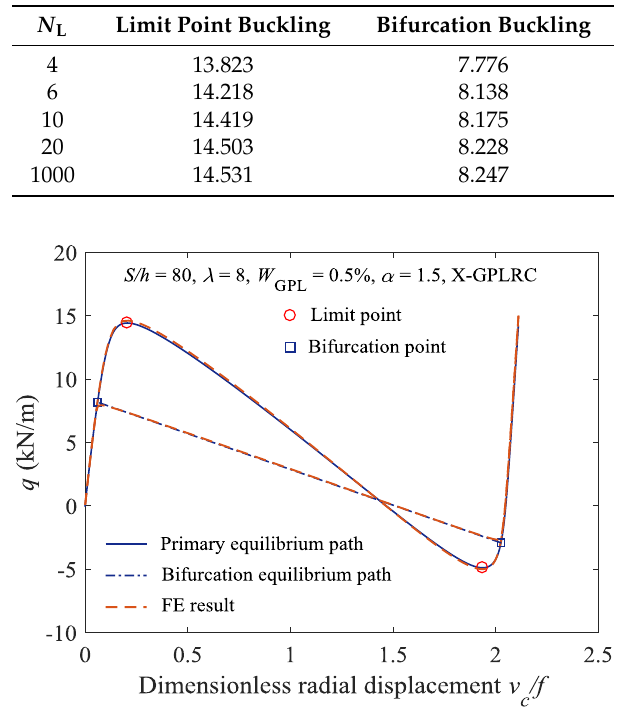
Figure 3. Comparison of analytical results and finite element (FE) results.